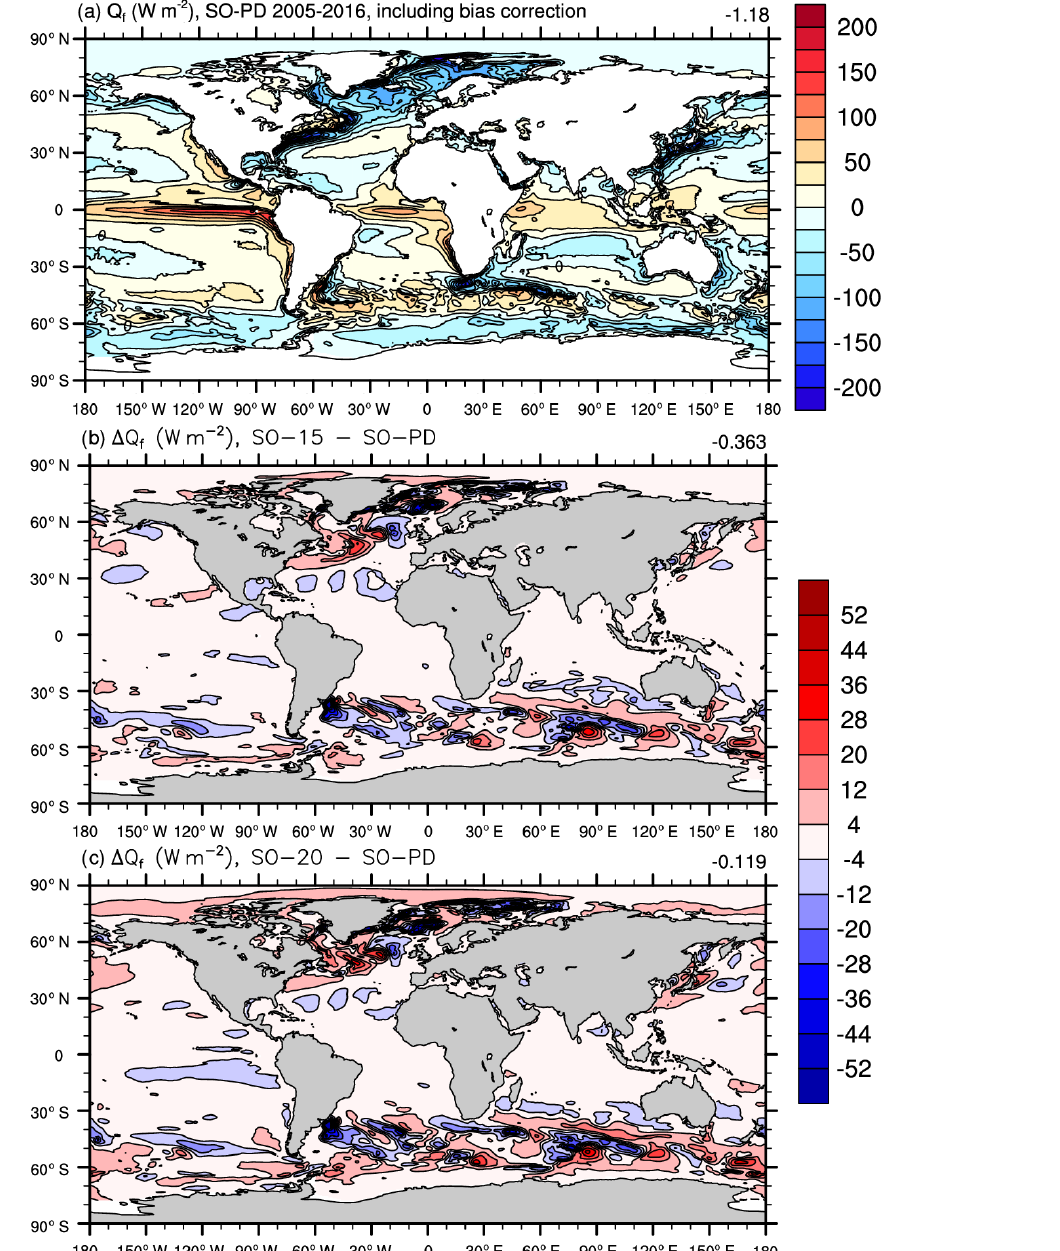
Figure 6. The annual-mean ocean heat flux ( Q f ) needed in NorESM1-HappiSO to maintain a stable PD climate that is close to the observed SST used during calibration (a) , and the change in Q f for SO-15 (b) and SO-20 (c) compared to SO-PD. Negative values contribute to increasing SST (Eq. 1). Units are in Wm − 2 (a–c)